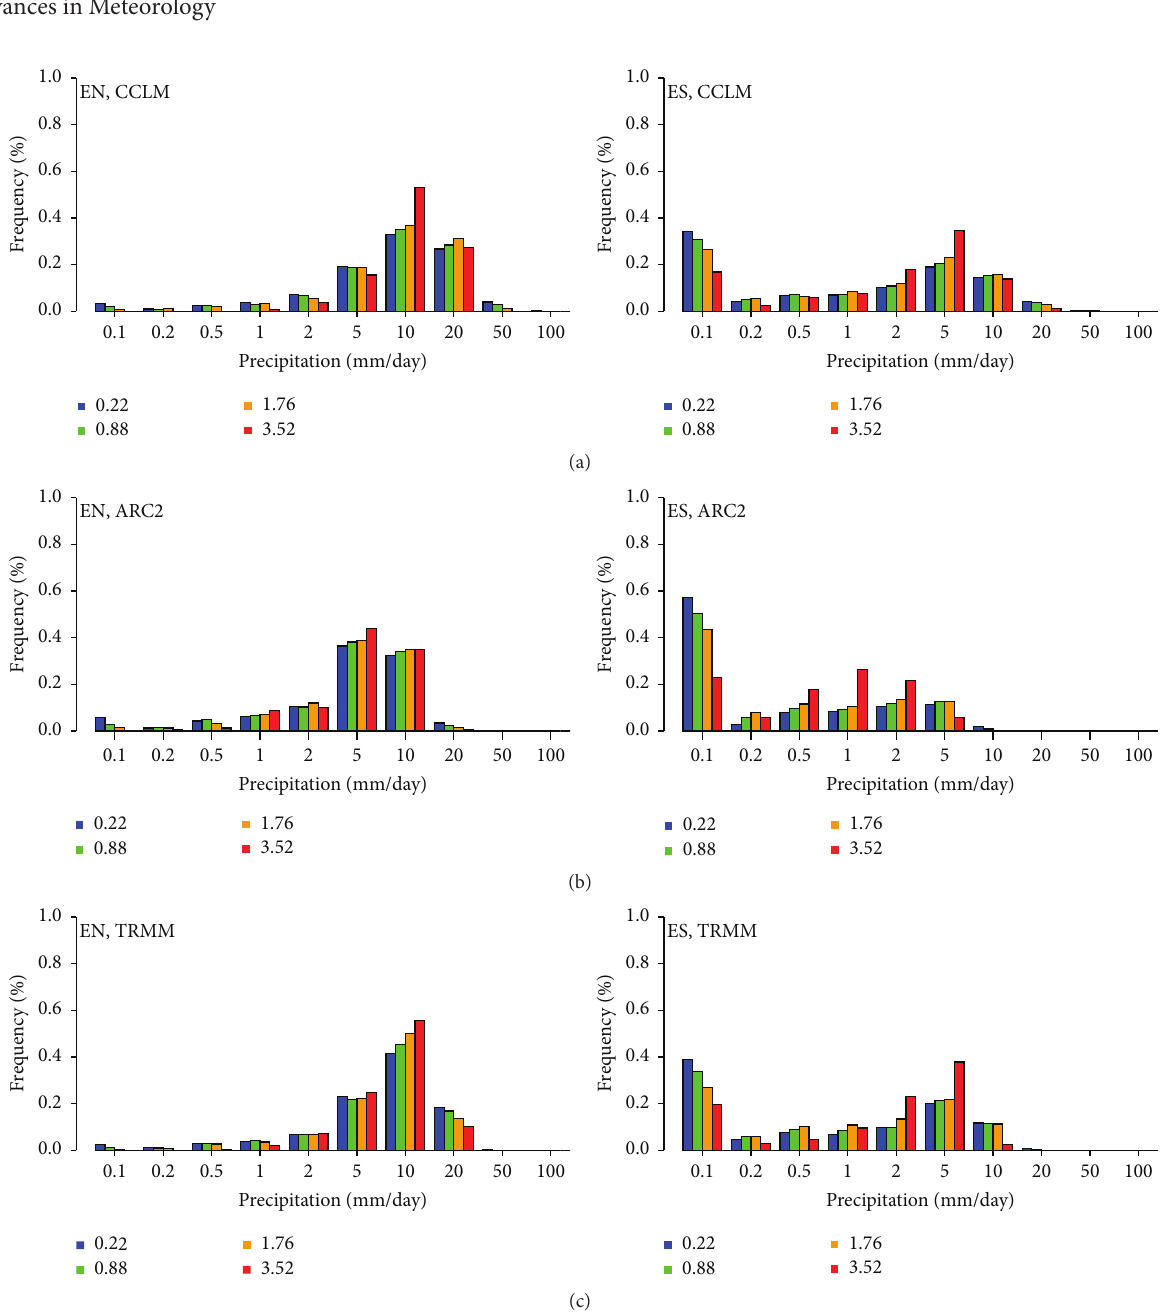
fine resolution, while medium range precipitation frequency is captured at coarse